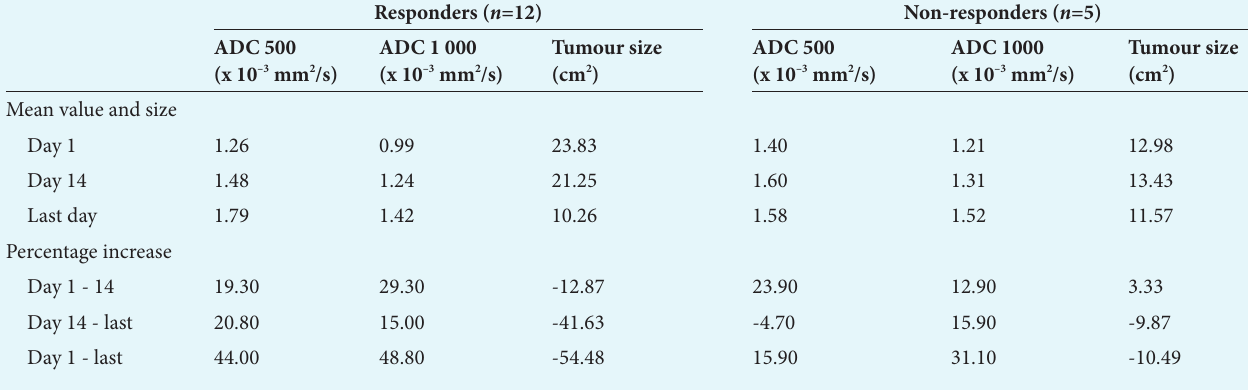
Table 3. Comparison of ADC values and tumour size in responders and non-responders to